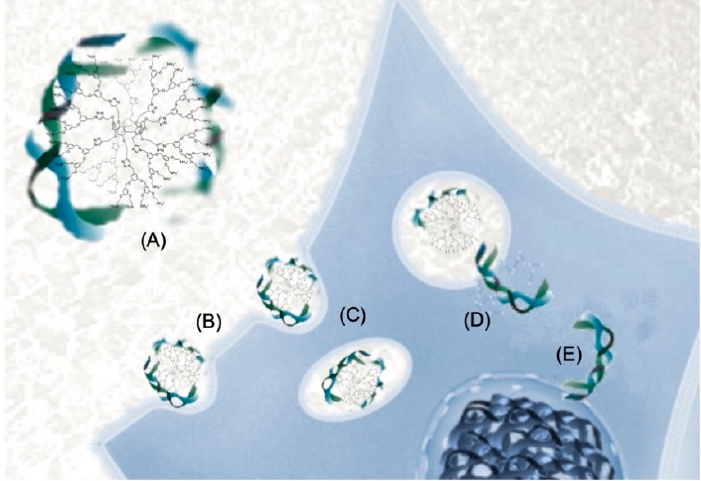
Figure 4. Schematic representation of the main step of gene delivery into a cell: ( A ) complexation of DNA; ( B ) interaction with the cellular membrane; ( C ) entry into the cell; ( D ) release into the cytosol; ( E ) intracellular transport into the nucleus where the DNA is expressed.